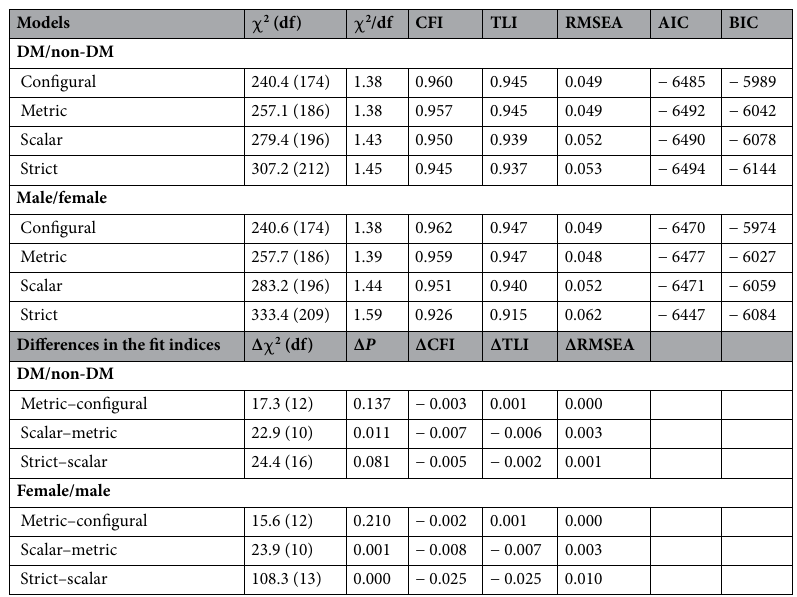
Table 4. Measurement invariance across diabetes status and gender in multi-group CFA. DM diabetes mellitus, χ 2 chi-square, df degree of freedom, Δ χ 2 chi-square difference, AIC Akaike Information Criterion, BIC Bayesian Information Criterion.